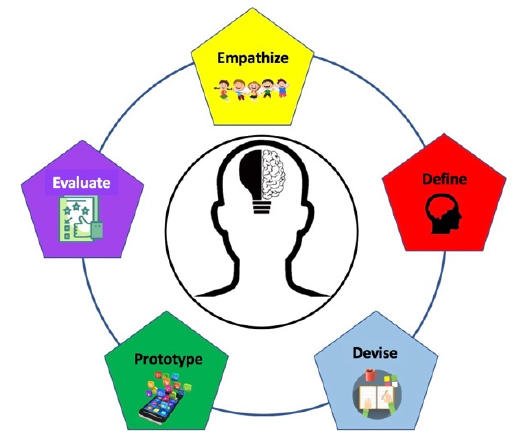
Figure 1. Stages of the design thinking methodology.